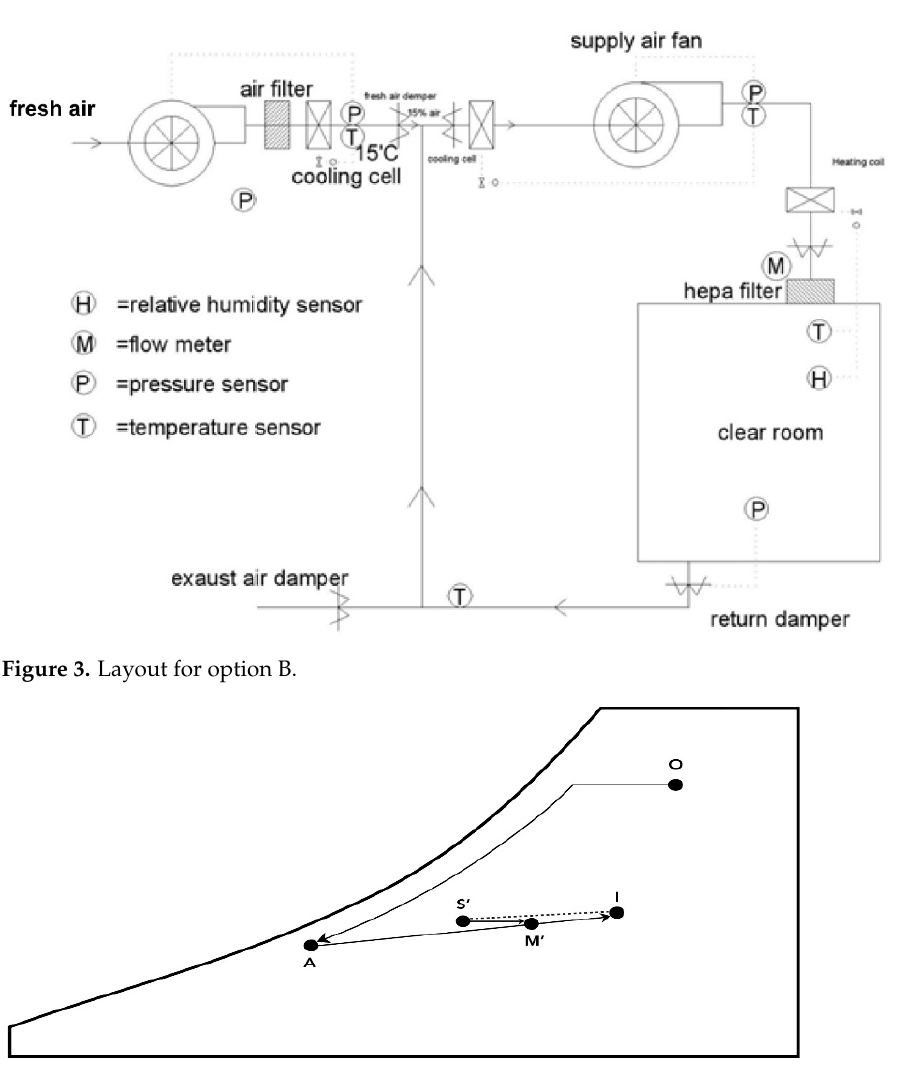
Figure 4. Psychometric chart for option